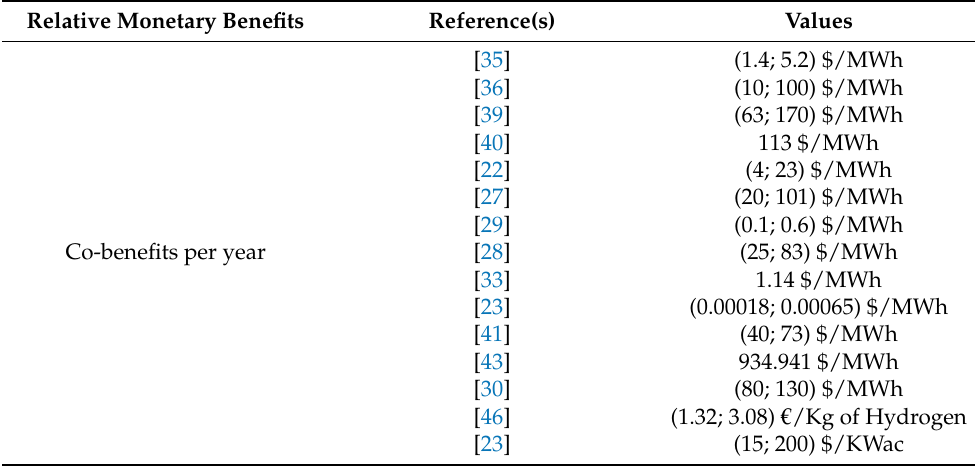
Table 11. Relative monetary benefits (source: own